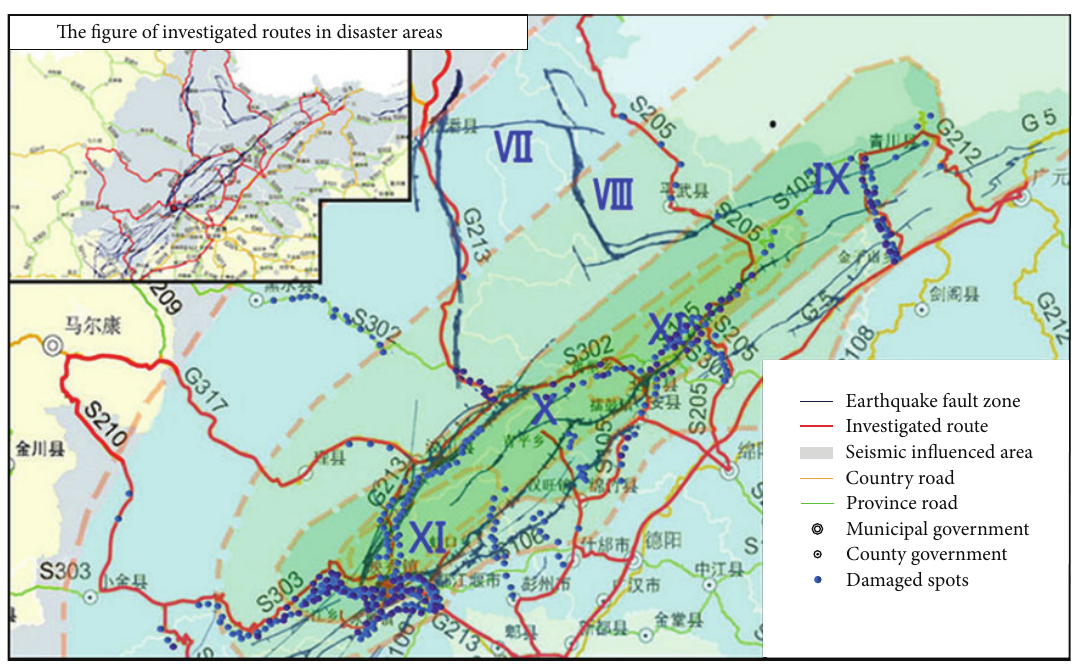
Figure 1: Roads investigated and seismic